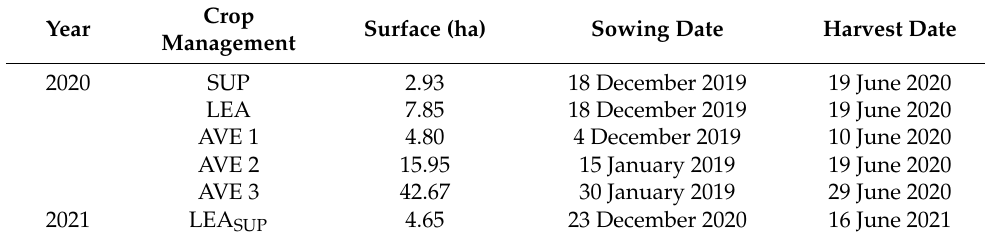
Table 1. Monitored barley plots.